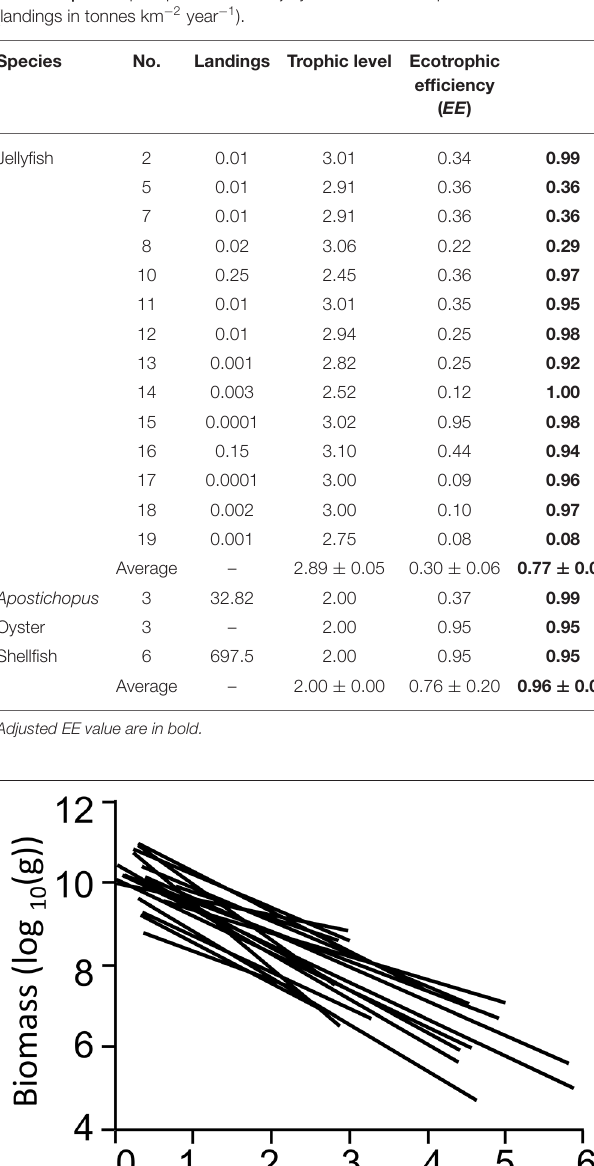
TABLE 3 | Ecotrophic parameters for jellyfish and farmed species in China’s seas (landings in tonnes km − 2 year − 1 ). Species No. Landings Trophic level Ecotrophic